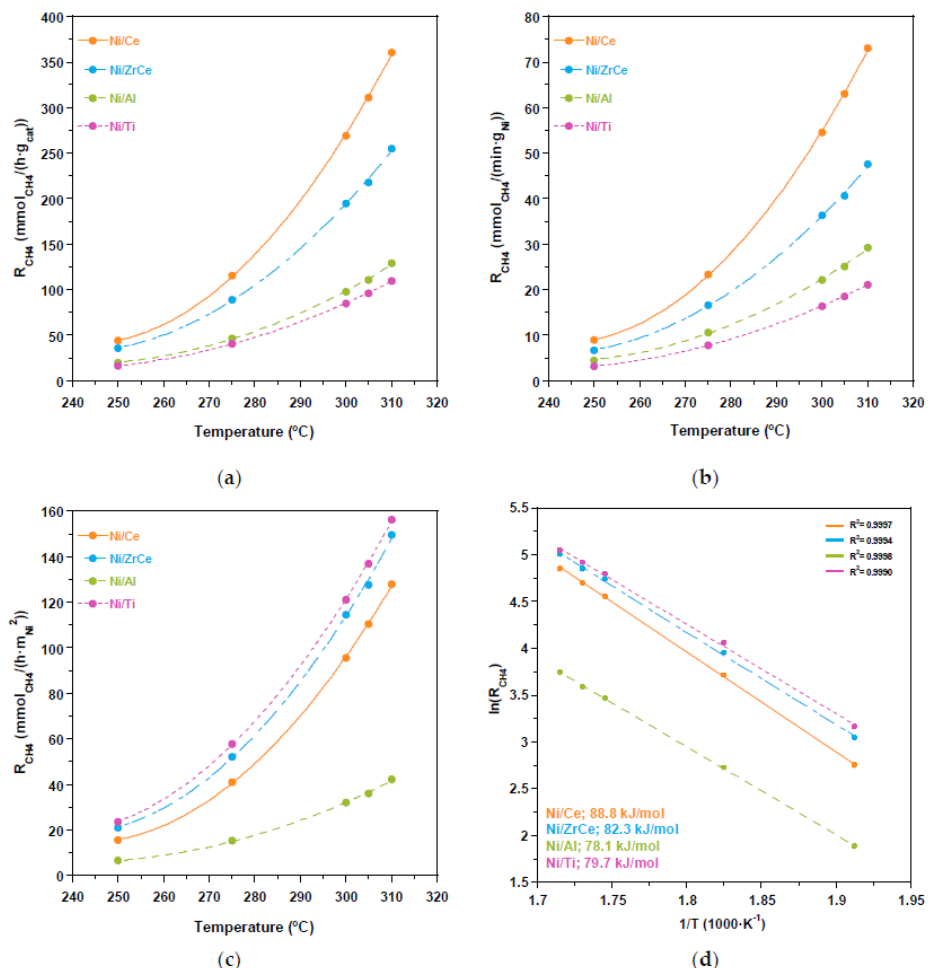
Figure 5. Methane formation rates expressed per g of catalyst ( a ), g of Ni ( b ), and m 2 of Ni ( c ), as obtained from experiments conducted at the temperatures indicated, atmospheric pressure, and H 2 /CO 2 molar ratio in the reactor feed of 4. Arrhenius plots based on the methane formation rates normalized to the Ni metallic area ( d ).